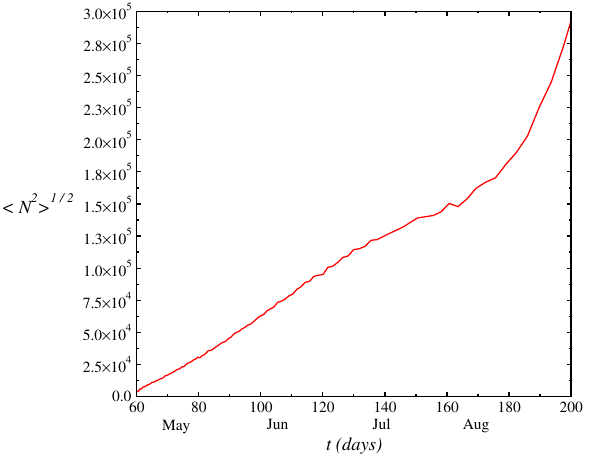
Figure 5. Mean square deviation root Brownian motion.